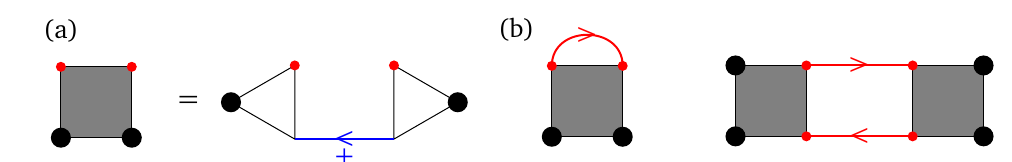
Figure 4: (a) The interaction vertex of the effective single-band theory (left-hand side) can be expressed in terms of the original vertices and the electronic band that is integrated